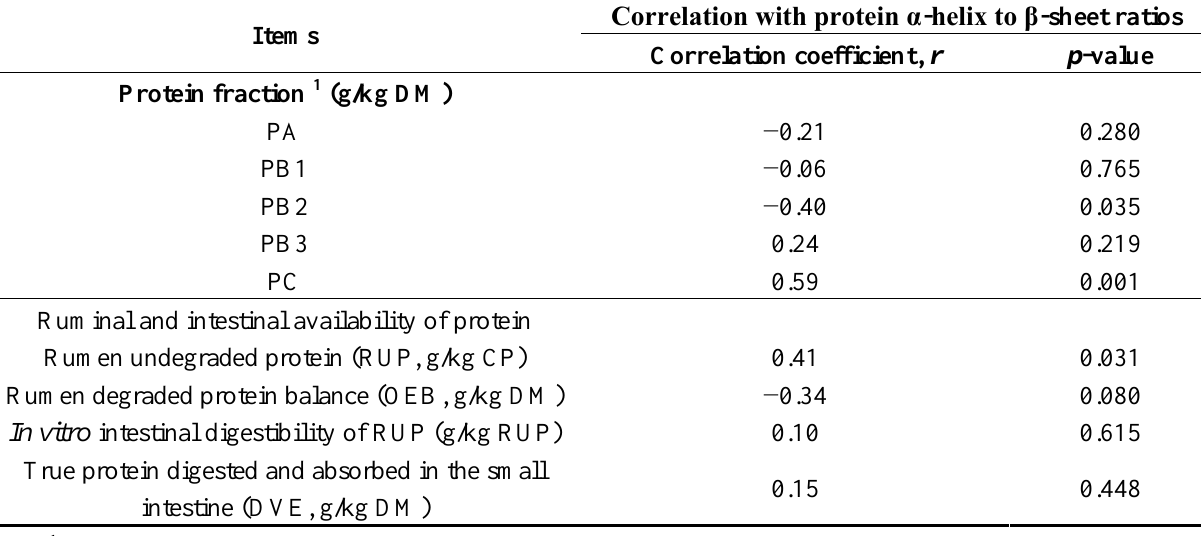
Table 6. Correlation between α-helix to β-sheet ratios and protein sub-fractions, and ruminal and intestinal availability of protein based on the DVE/OEB 2010 protein evaluation system in the different types of